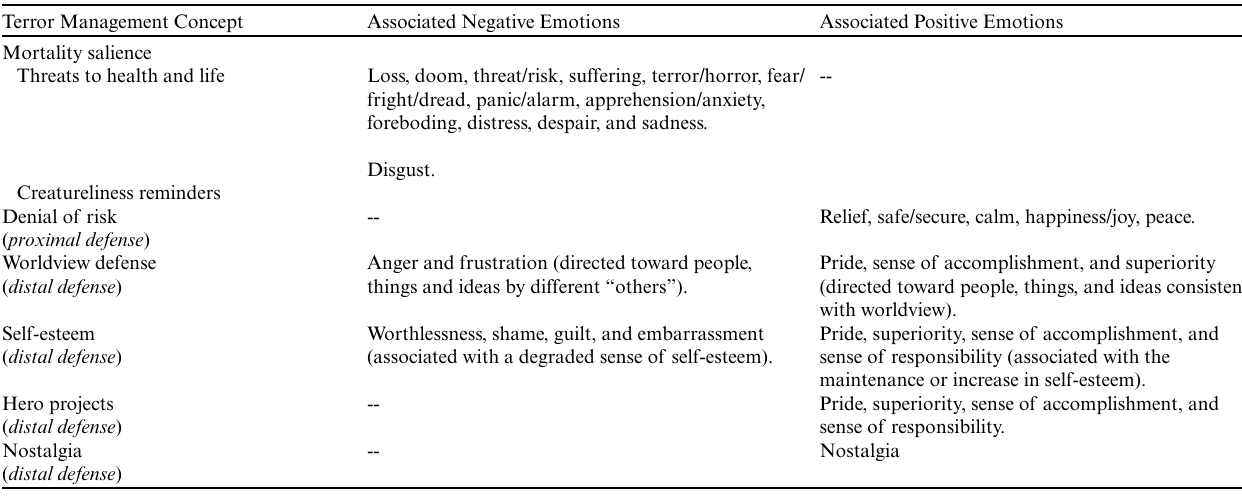
Table 1. Positive and negative emotions associated with seven terror management